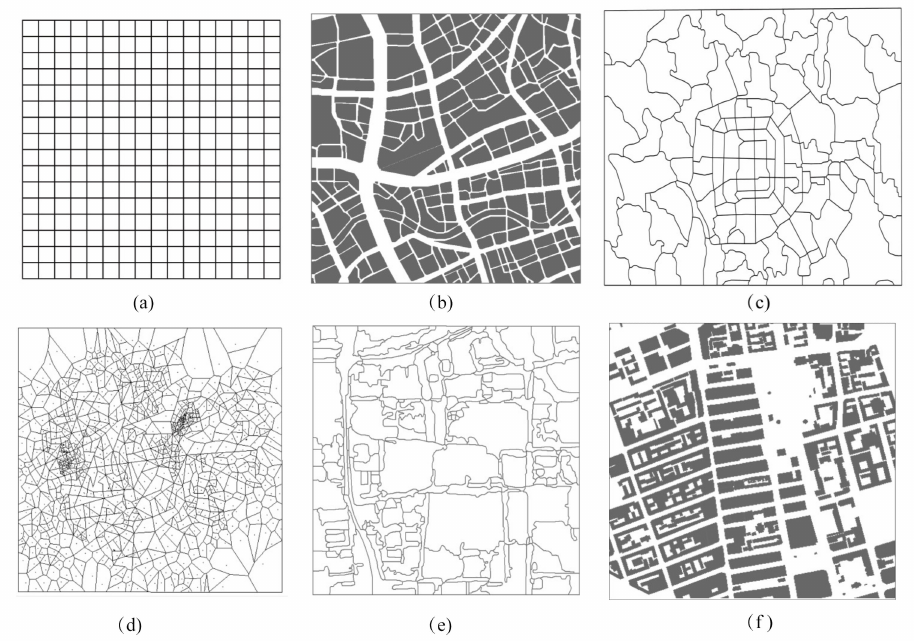
Figure 4. Different units of urban functional zone ( a ) grid, ( b ) block, ( c ) traffic analysis zone (TAZ), ( d ) clustering unit, ( e ) geoscene, ( f ) building unit.